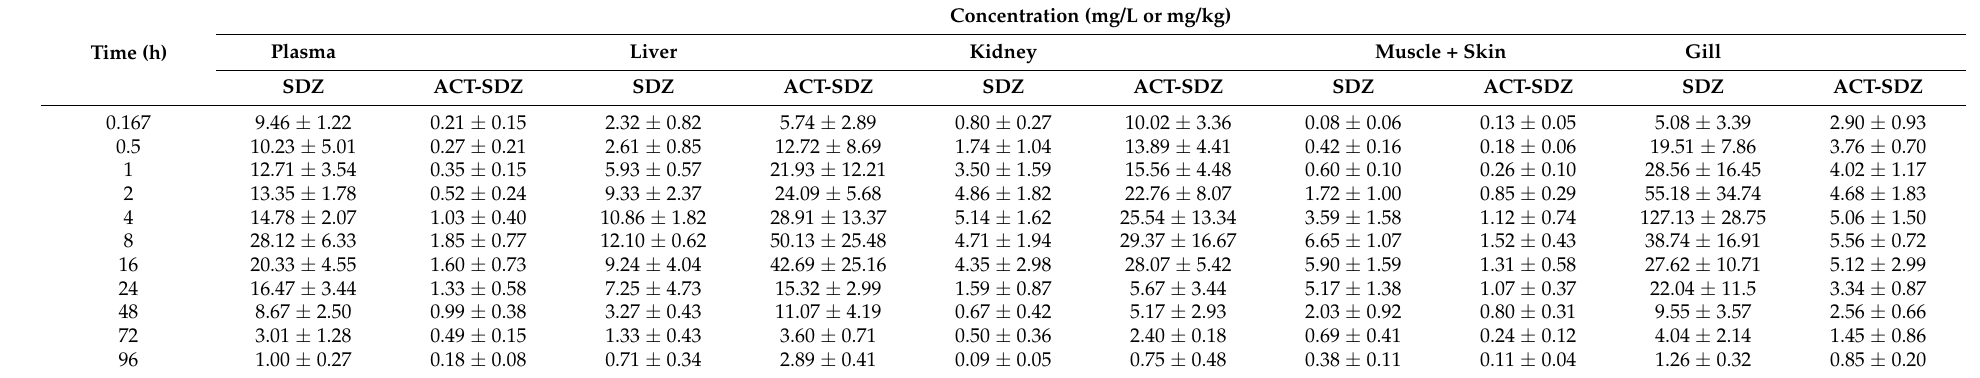
Table 2. Sulfadiazine and N-acetyl sulfadiazine concentrations in plasma and tissues of grass carp ( Ctenopharyngodon idella ) after oral administration of a single dose of sulfadiazine at 50 mg/kg at 24 ◦